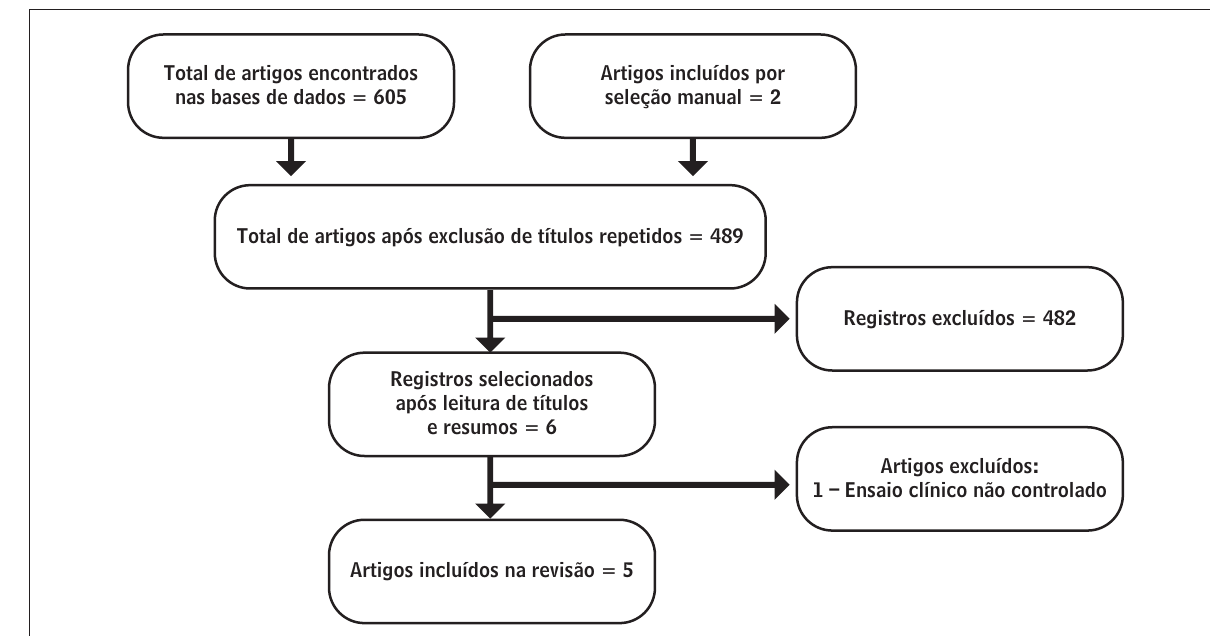
Figura 1 - Fluxograma do processo de seleção dos estudos Fonte: Dados da